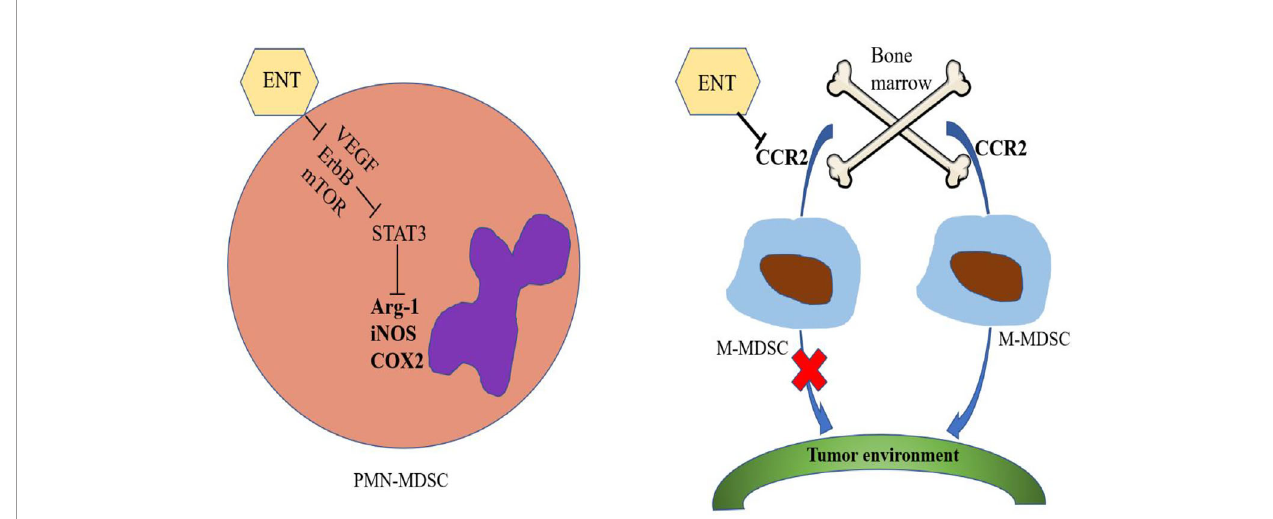
FIGURE 1 | Effects of entinostat on MDSCs. Entinostat inhibits the VEGF, ErbB and mTOR pathways in PMN-MDSCs, thereby inhibiting the activity of STAT3, which in turn reduces the activities of Arg-1, iNOS and COX2. Entinostat therapy inhibits the transport of M-MDSCs from bone marrow to the tumor environment by downregulating CCR2